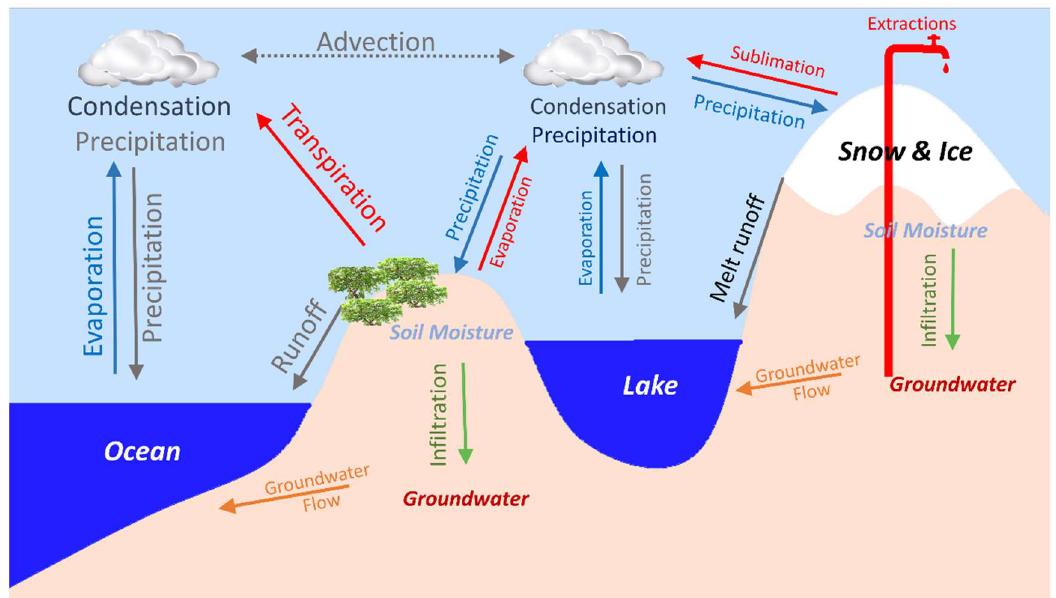
Figure 2. GRACE based total water storage variations are a composite of various continental water storage compartments.